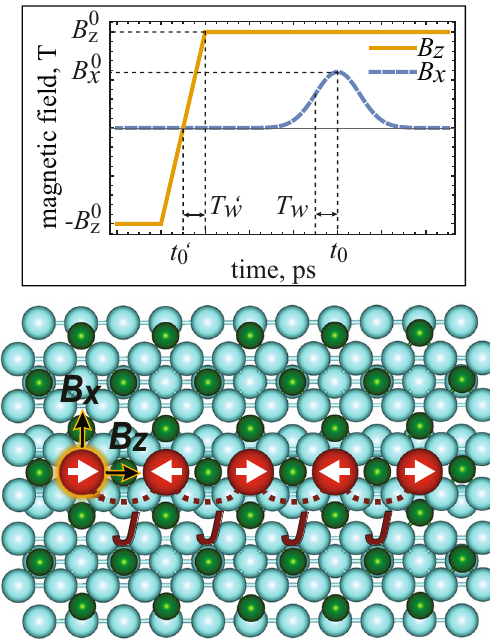
Figure 1. Upper inset: Time-dependent magnetic pulse B x and field B z applied to the edge atom in the chain. 0 and ascribed by a center of filed ′ t The step-like reversible field B z is determined by amplitude B (set at 30 ps ) 0 z with a half-width ′ T (set at 10 ps ), whereas Gaussian-like pulse B x ( t ) is determined by amplitude B x 0 (set at 0.5 w T ) and ascribed by a shift of the pulse t 0 (set at 100 ps) with a half-width T w (set at 10 ps ). Lower inset: Schematic view of a finite cobalt chain (Co 5 ) placed on a self-corrugated Cu 3 N/Cu(110) surface. The red (large dark) spheres indicate the Co atoms, the green (small dark) spheres indicate the N atoms, and the turquoise (light) ones indicate the Cu atoms, respectively. The exchange parameter J indicates spin coupling between cobalt atoms in neighboring